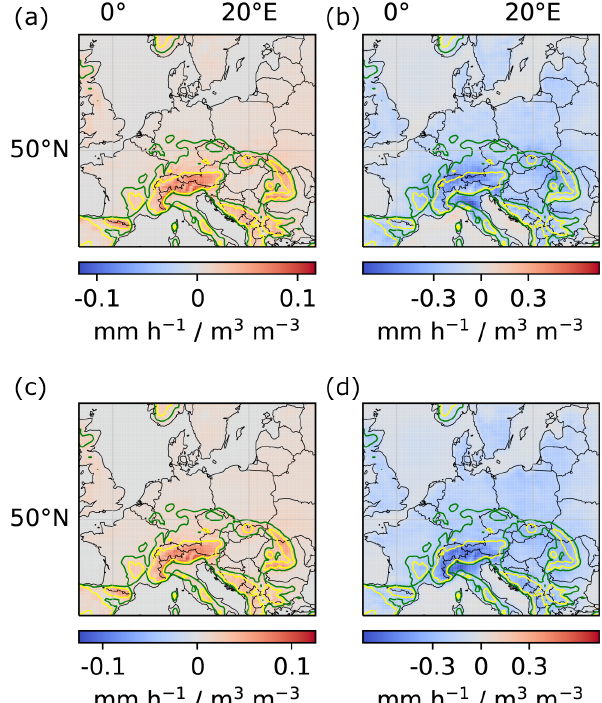
Figure A1. Local and regional soil-moisture–precipitation cou- plings for models trained on the first and second half of the train- ing years, respectively. (a, c) Local couplings. (b, d) Regional cou- plings. (a, b) Model trained on the first half of all training years (1979–1997). (c, d) Model trained on the second half of all training years